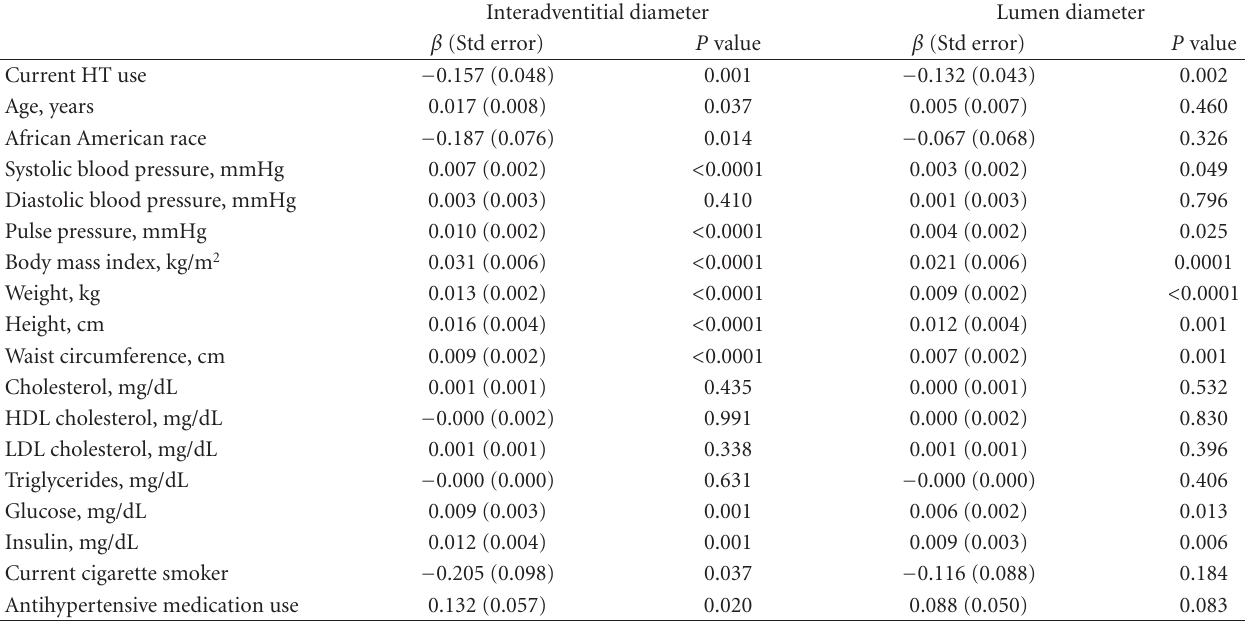
Table 3: Univariate linear regression showing the association of demographic and cardiovascular risk factors with common carotid artery